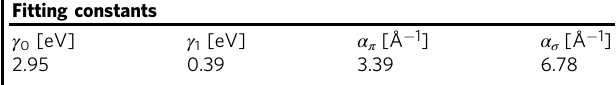
Table 1 Parametrization of t ( ∣ r ∣ , z ) Values of fi tting parameters describing the carbon-carbon potential t ( ∣ r ∣ , z ) from Eq. (3).